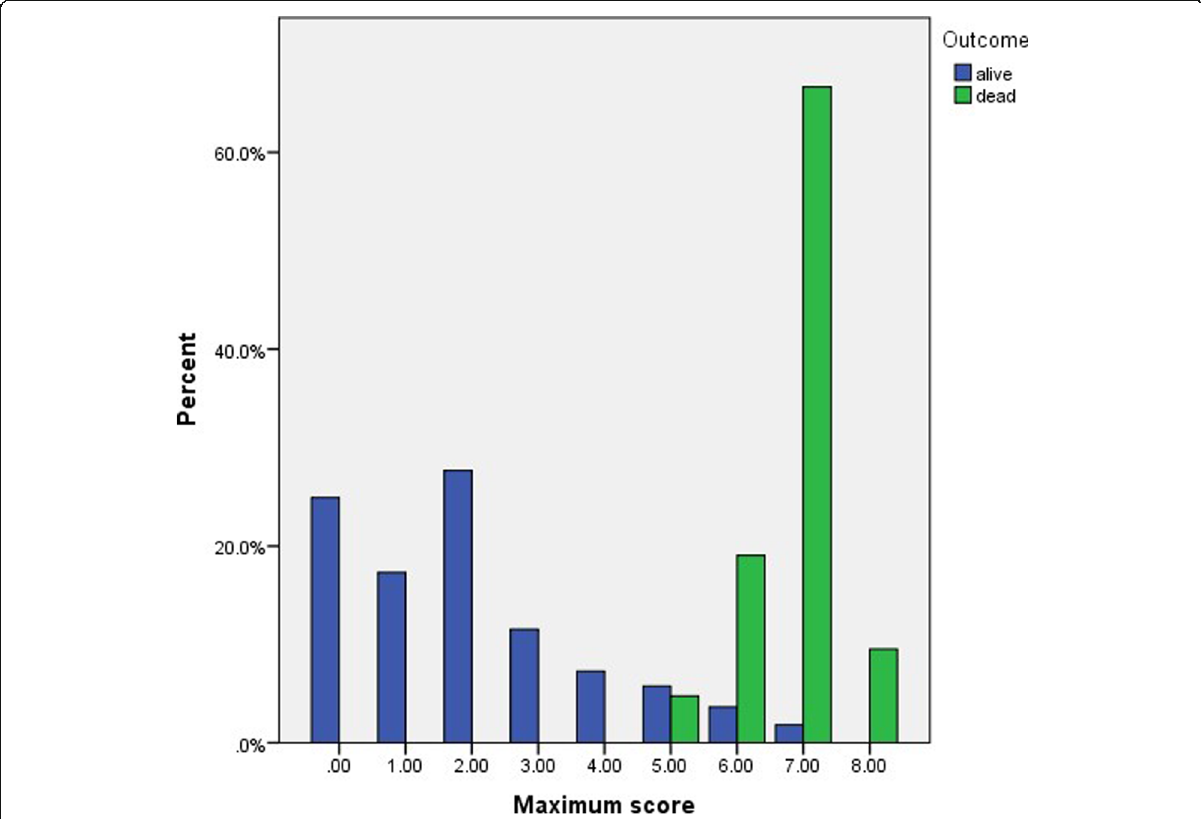
Fig. 13 Percentage distribution of maximum score and